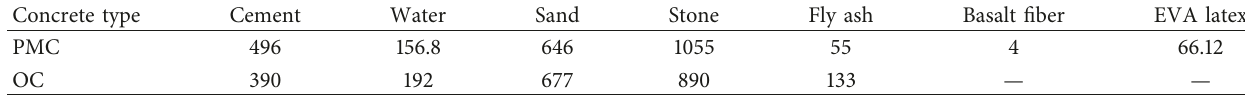
Table 2: Mix proportions of concrete (kg/m 3 ).